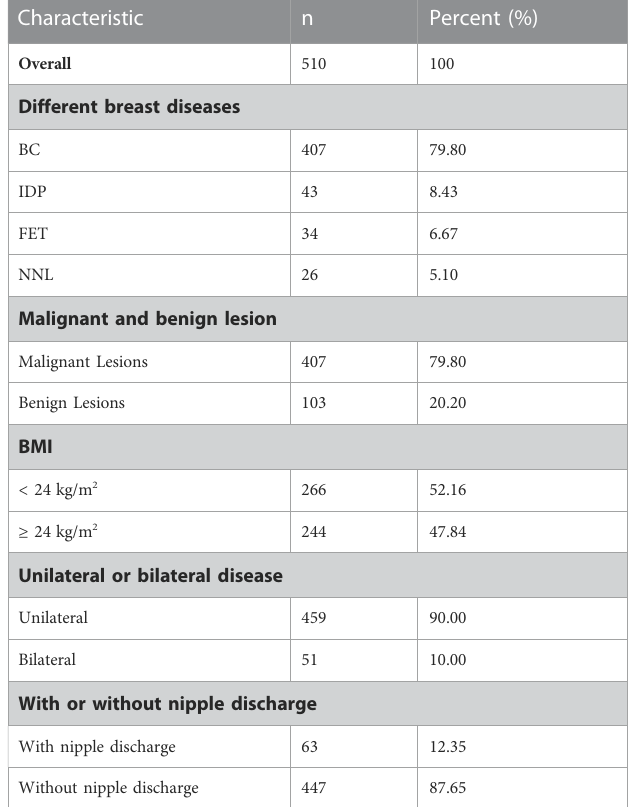
TABLE 1 Characteristics of premenopausal women with breast diseases. Characteristic